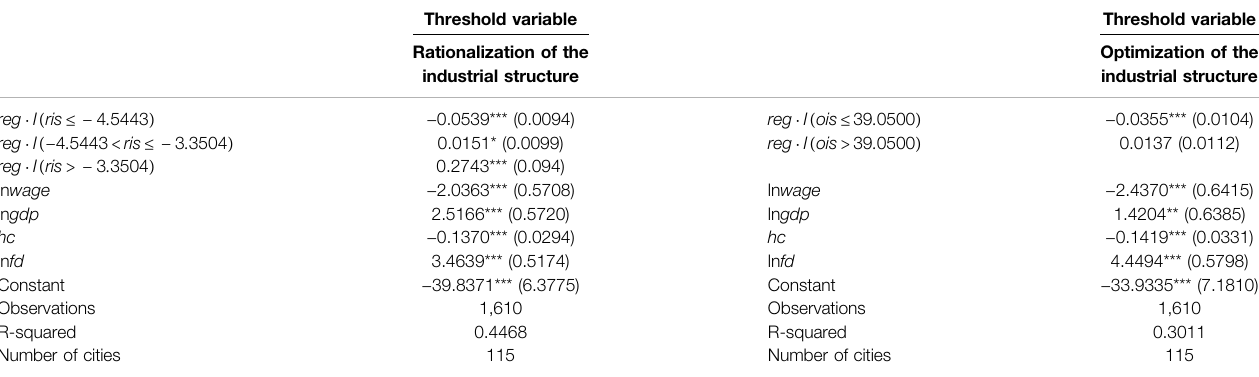
TABLE 5 | Robustness test.